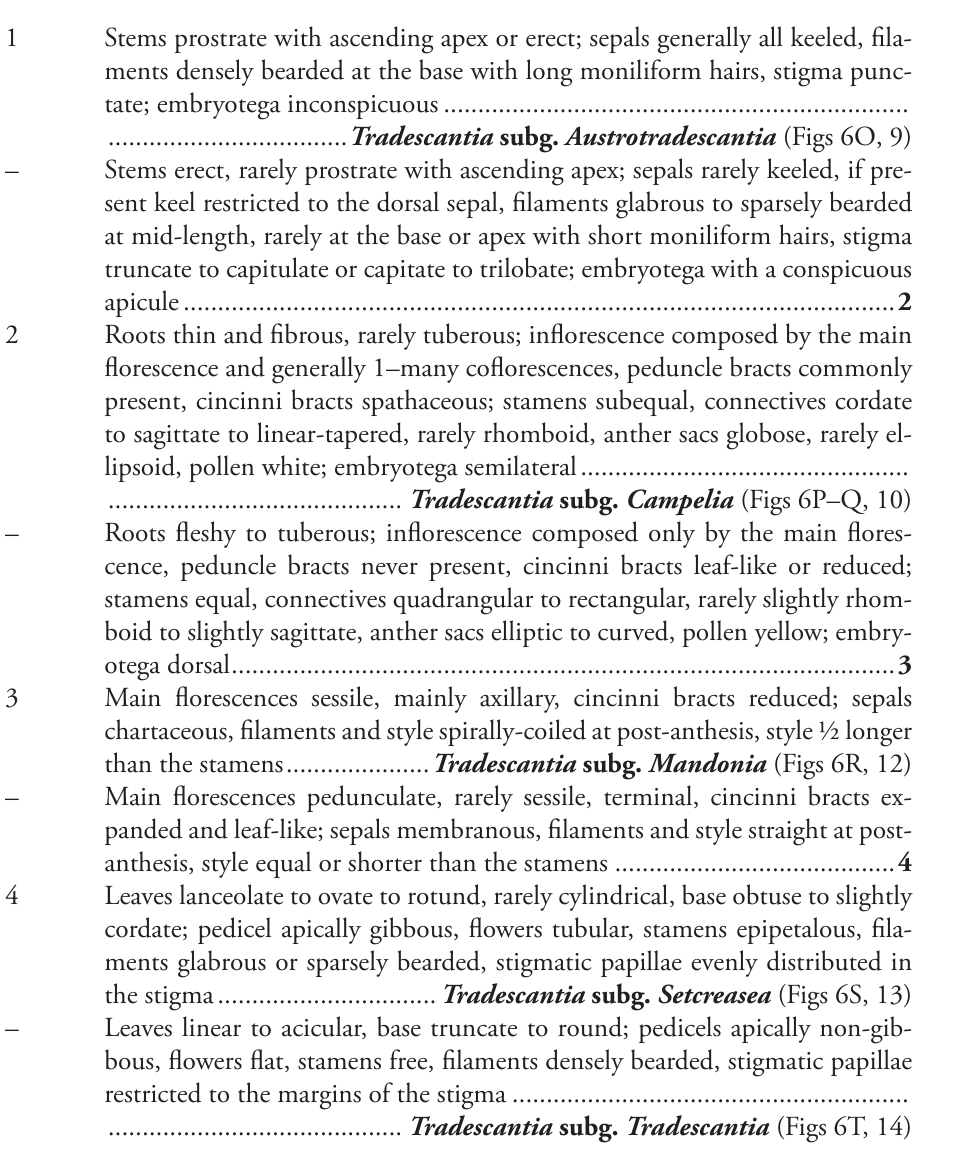
present, cincinni bracts spathaceous; stamens subequal, connectives cordate